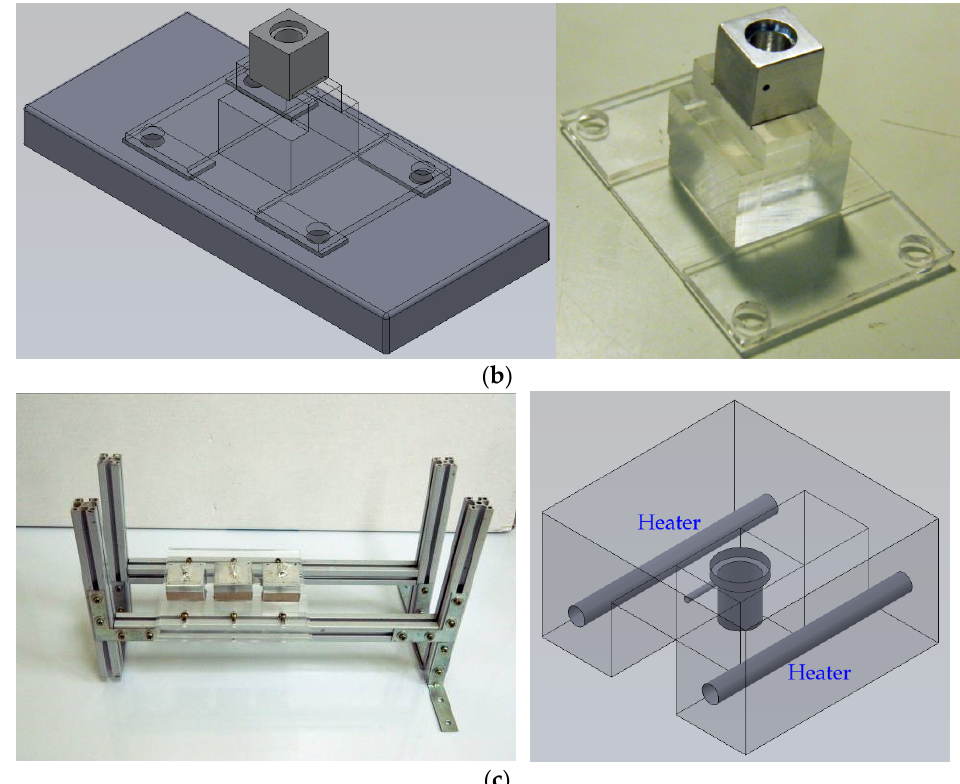
Figure 1. ( a ) The schematic diagram of the oscillating thermocycler. ( b ) The schematic diagram and the photograph of the aluminum chamber, PMMA block and sheet. ( c ) The photograph and schematic diagram of three heating blocks. Each consists of two heaters, one thermal sensor and an aluminum block.